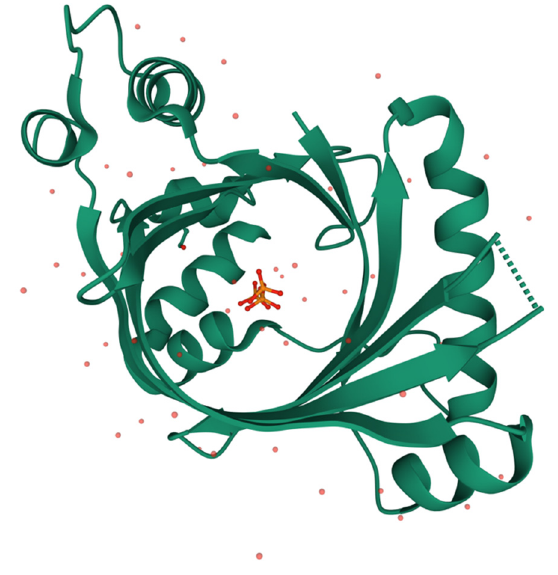
Figure 5. Three-dimensional structure of human THTPA in complex with inorganic tripolyphosphate (RCSB PDB ID 3TVL, https://www.rcsb.org) [41]. Image created using Mol* [88].